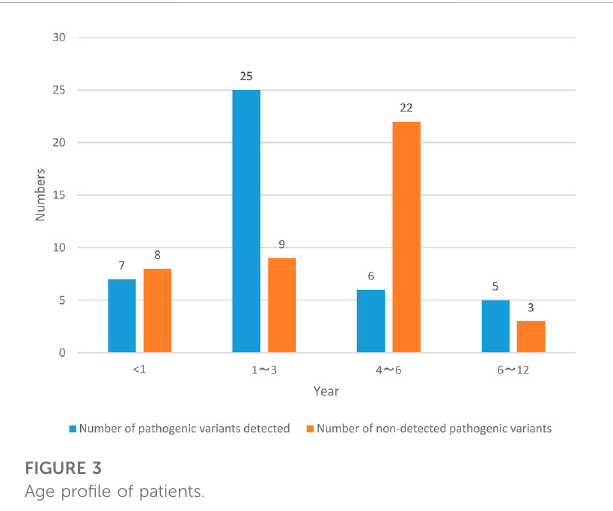
FIGURE 3 Age pro fi le of